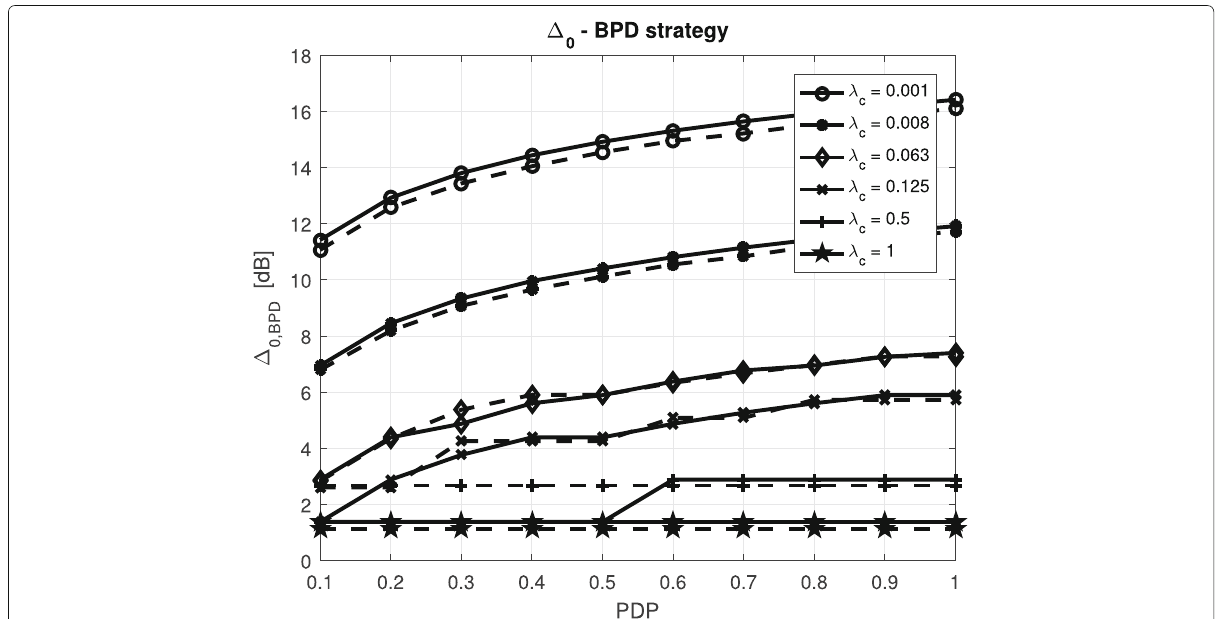
Fig. 7 Factor (cid:9) 0,BPD for frequency selective Rayleigh channel model. Factor (cid:9) 0,BPD [dB] vs. the parameter PDP for different frequency selectivity values λ C , γ E = ∞ and G ant = 40 dB. Continuous lines are derived analytically and dashed lines from simulations